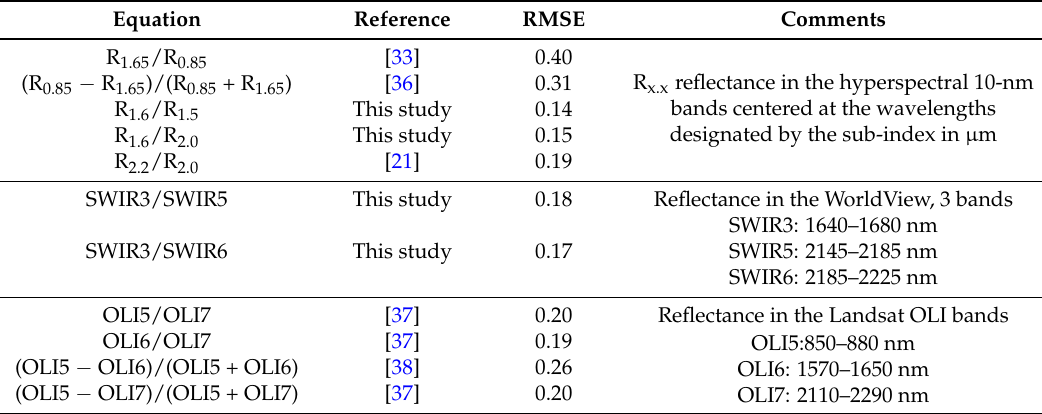
Table 3. Equations of the spectral indices used to estimate the relative water content and the root mean square error (RMSE) of the linear-plateau model fitted to the data collected in the laboratory